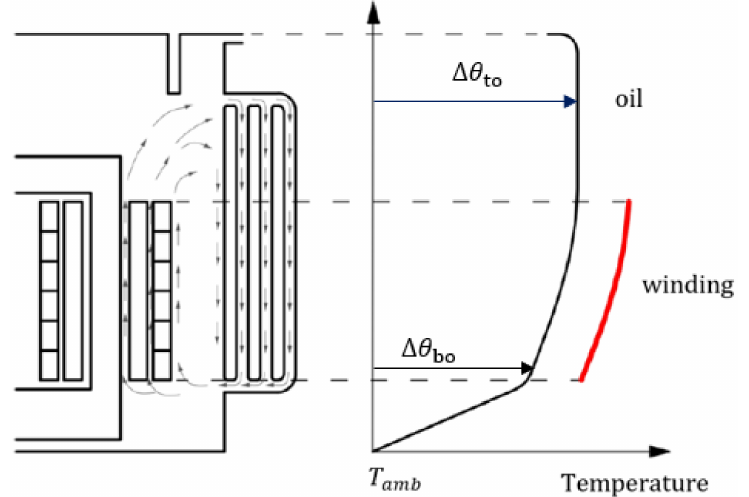
Figure 5. Temperature distribution in power